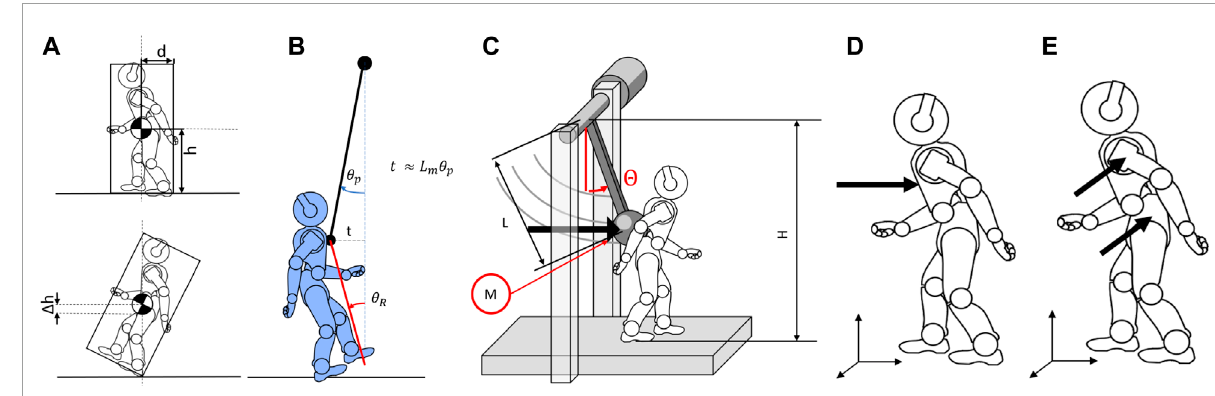
FIGURE 3 Schematic visualization of the model for (A) the force and energy normalization factor computation and (B) the displacement normalization factor. (C) Model of the structure reporting the main dimensions of the system. (D,E) Definition of the impact position for (B) frontal perturbations and (C) sagittal